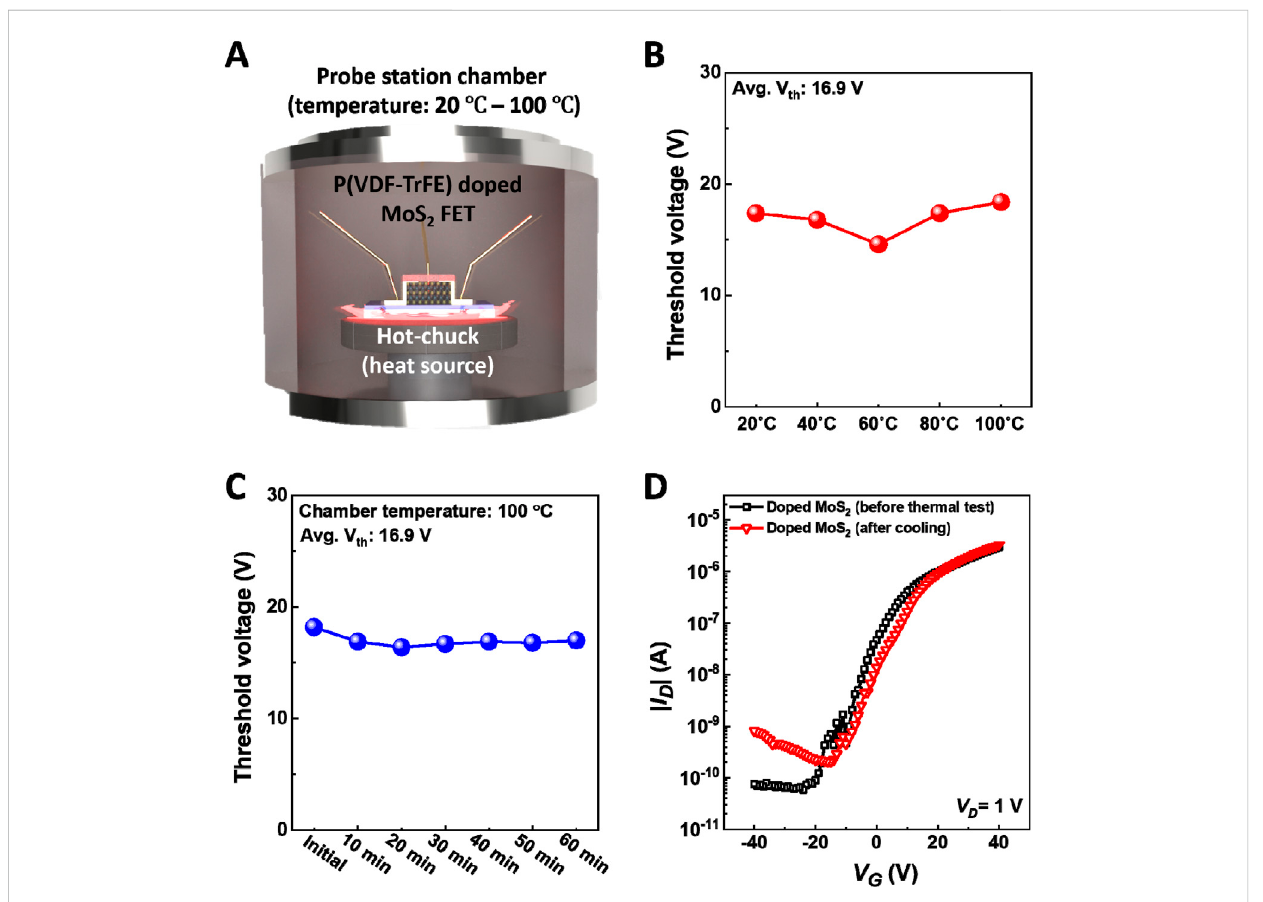
FIGURE 4 (A) 3D schematic description of the thermal stability characterization environment. Threshold voltage change according to the experimental conditions: (B) during the chamber temperature increasement from 20 to 100 ° C, (C) continuous 100 ° C environment condition for 1 h. (D) Transfer curves of the P(VDF-TrFE)-doped MoS 2 FET (200 ° C) before and after the thermal stability